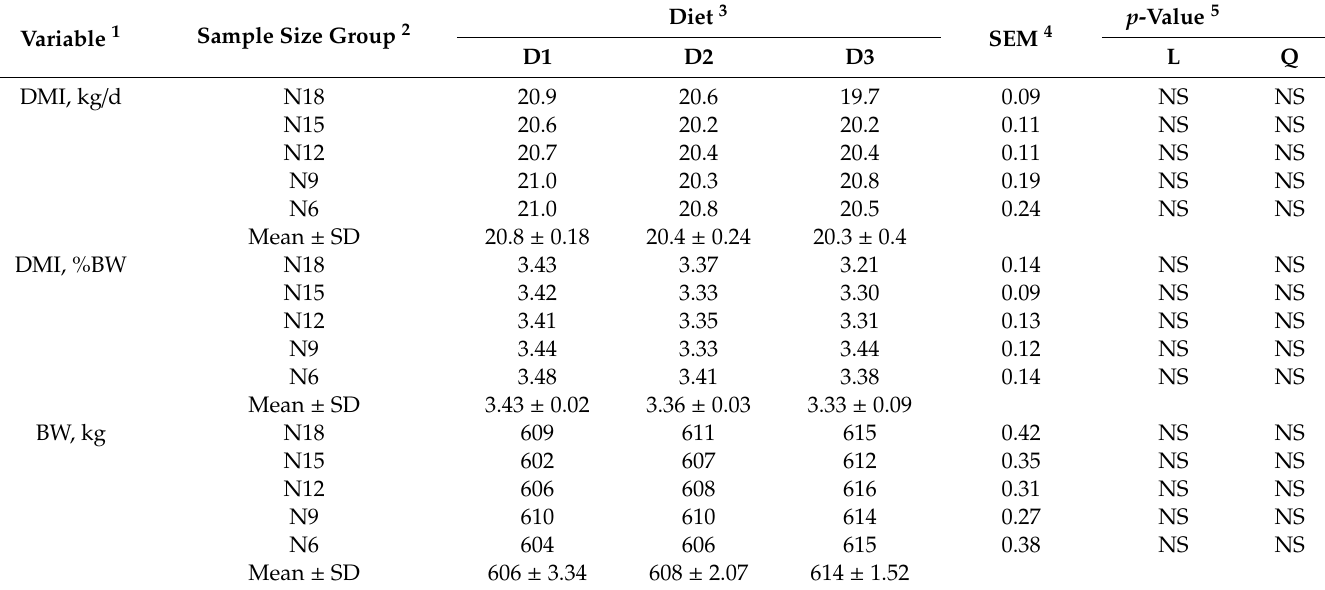
Table 3. E ff ect of diet on body weight and dry matter intake of lactating dairy cows fed corn-based diets in di ff erent sample size groups ( n = 162). Variable